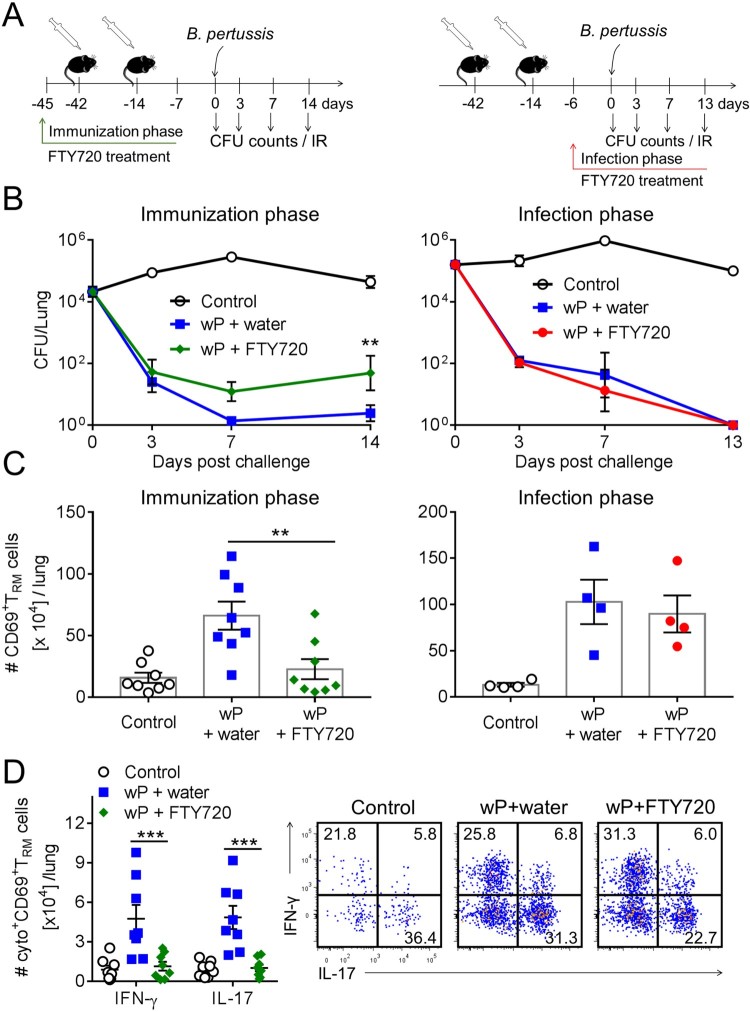
Preventing lymphocyte migration from lymph nodes during wP immunization suppresses accumulation of CD4 TRM cells in the lungs and impairs protection. (a) Schematic of experimental plan; C57BL/6 mice were immunized with a wP vaccine 6 and 2 weeks before challenge with B. pertussis. wP-immunized mice were given FTY720 in the drinking water during the immunization phase (3 days before 1st immunization until 7 days after 2nd immunization) or during infection (6 days before B. pertussis challenge and during infection). (b) CFU counts in the lungs at intervals after aerosol challenge with B. pertussis. Lung CFU counts (left graph: mean ± SEM n = 8 mice per group per time-point in two independent experiments; right graph: mean ± SEM n = 4 mice per group per time-point). **p < .01 versus wP + FTY720 by two-way ANOVA with the Tukey’s post-test, only significant differences between experimental groups are indicated. Seven days post challenge, mice were injected i.v. with anti-CD45 antibody 10 min prior to euthanasia to discriminate circulating from tissue-resident leukocytes by flow cytometry. (c) Total number of CD69+CD4+ TRM cells. Results shown are mean ± SEM (left graph: n = 8 mice in two independent experiments; right graph: n = 4 mice). **p < .01 versus wP + FTY720 by one-way ANOVA with the Tukey’s post-test. (d) Total number of IFN-γ- and IL-17-secreting CD69+CD4+ TRM cells in the lungs with representative plots showing secretion of IFN-γ and IL-17 by CD45iv–CD44+CD62L–CD69+CD4+ T cells in wP-immunized mice treated with FTY720 during the immunization phase. Results shown are mean ± SEM (n = 8 mice in two independent experiments). ***p < .001 versus wP + FTY720 by two-way ANOVA with the Tukey’s post-test.